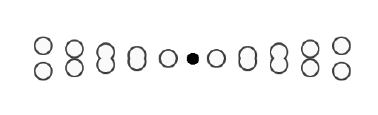
Figure 2 . Two circles merging, as seen by using various torsions in the coe(cid:14)cient groups of (co)homology. The change in the coe(cid:14)cient structure brings us from two independent circles to the wedge sum between two circles tangent at a common point, then to a single circle and (cid:12)nally to a simple point. The information is presented as seen by homology with various